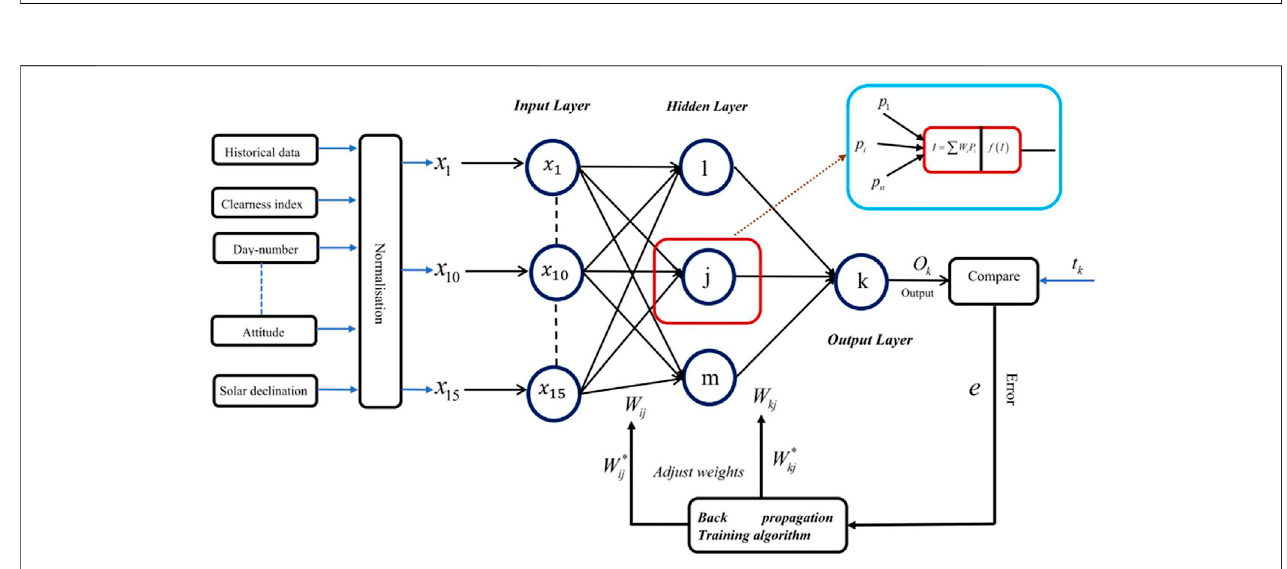
FIGURE 4 | Structure of used FFNN-BP